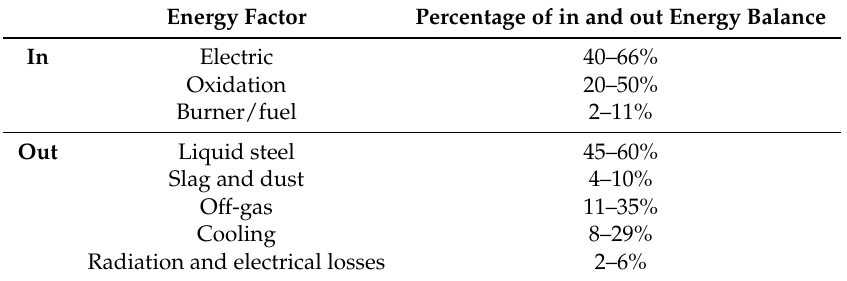
Table 2. Ingoing and outgoing energy in the EAF process as percentages of energy sources and energy sinks, respectively. Values are computed from a synthesis of reported values